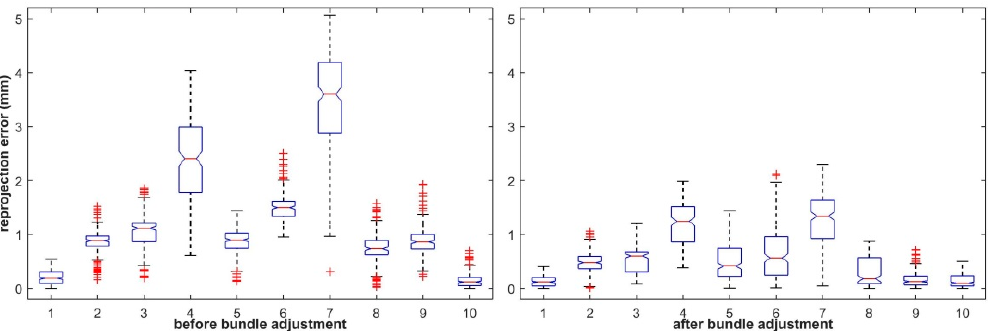
Figure 6. Reprojection errors of the initial and rectified points in the LLCS.